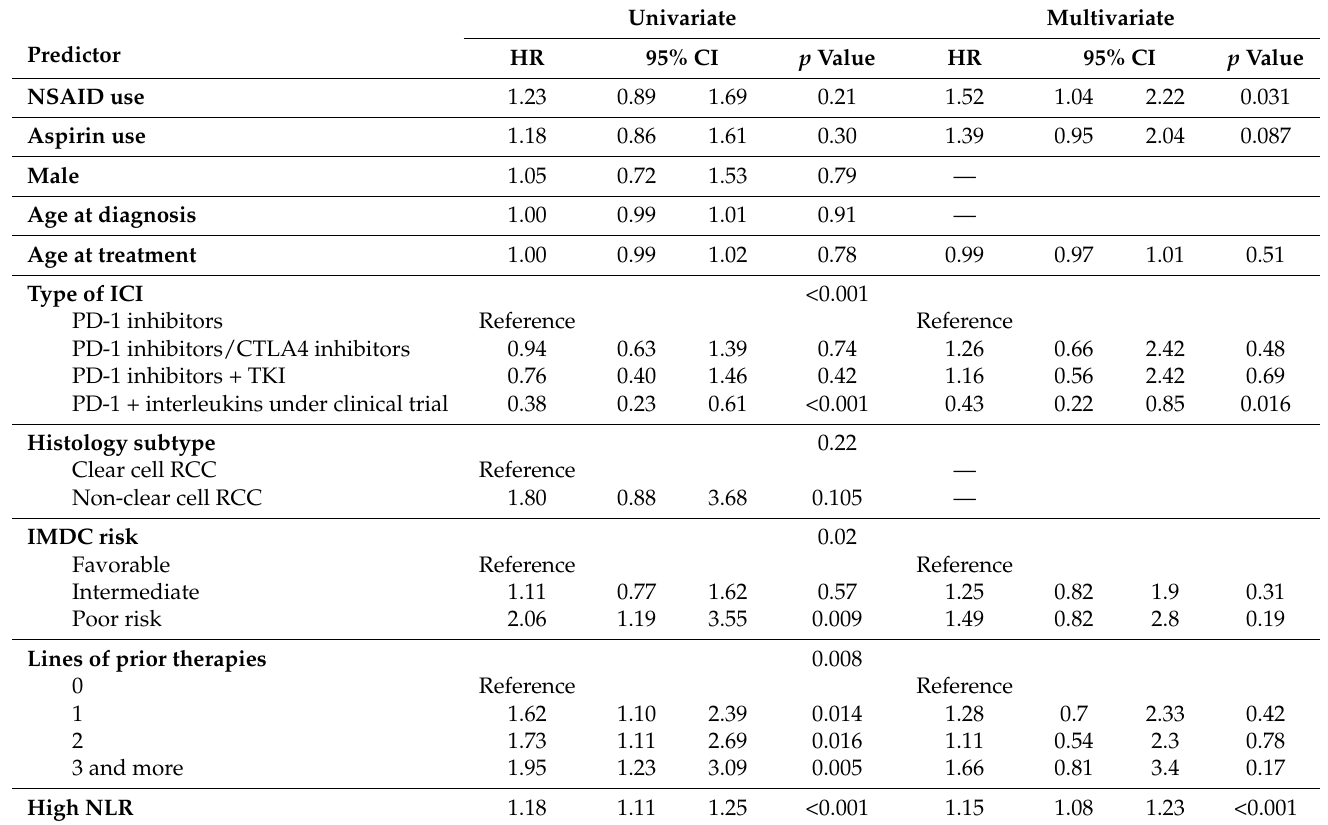
Table 3. Univariate and Multivariate Analysis of Factors Associated with